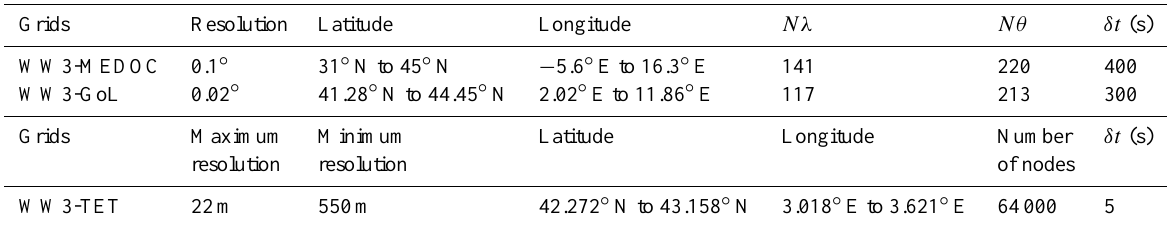
Table 1. Computational grids used in this study: Nλ and Nθ are the numbers of points in longitude λ and latitude θ , and δt is the maximum global time step.